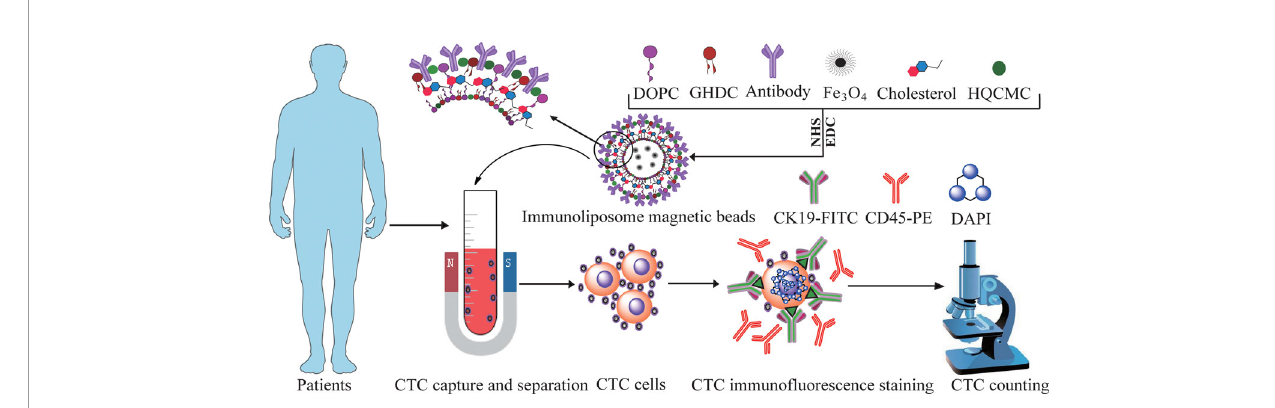
FIGURE 1 | Clinical blood CTCs and detection